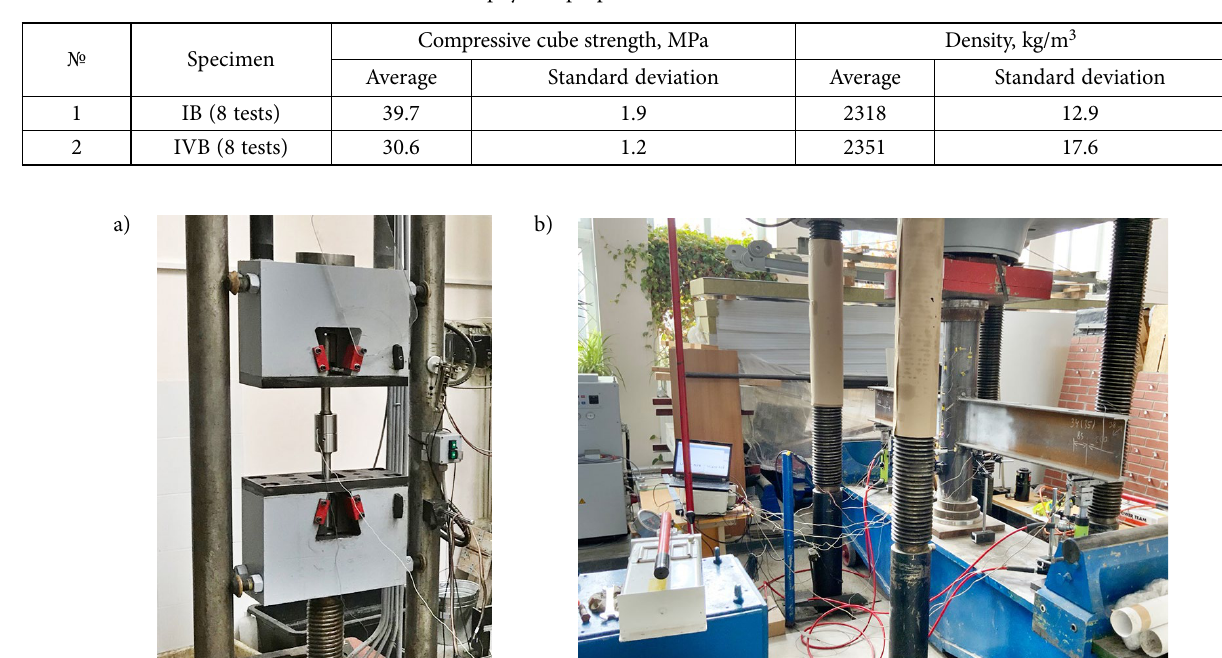
Table 2. Mechanical and physical properties of the 10×10×10 cm concrete cubes